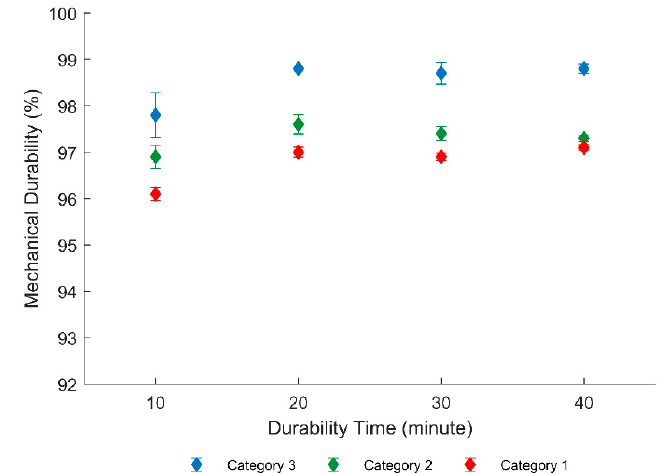
Figure 11. Mechanical durability values of sawdust pellets after several mechanical durability tests. Error bars show the standard deviation.